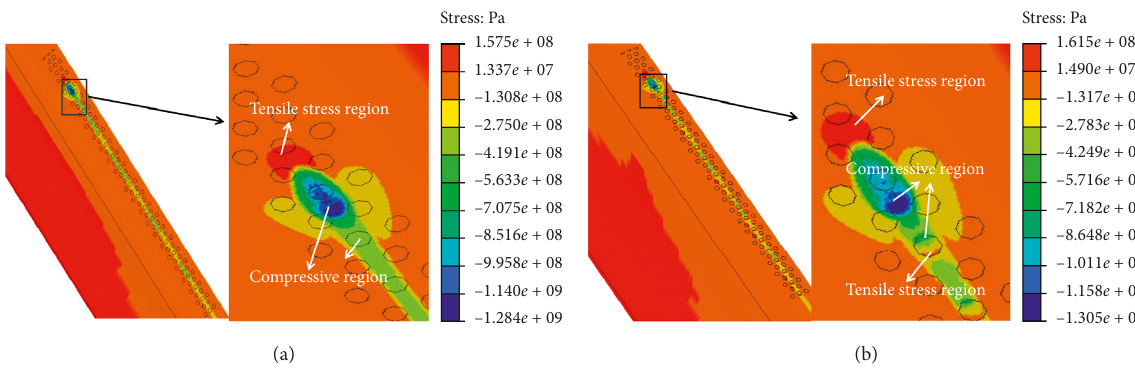
Figure 13: Field of longitudinal contact stress on the rail: (a) nonhardening material; (b) hardening material.